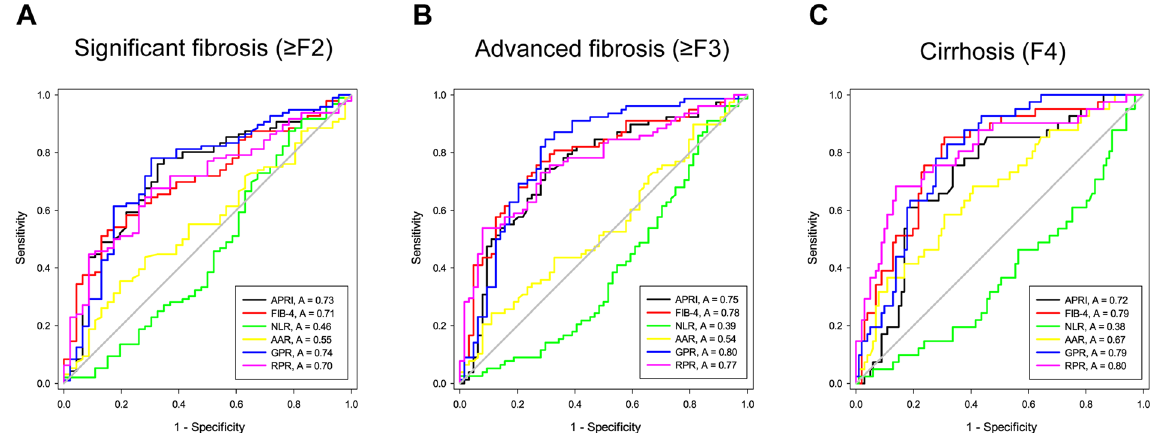
Figure 3. Receiver operating characteristic (ROC) curves of APRI, FIB-4, NLR, AAR, RPR and GPR in the prediction of significant liver fibrosis ( A ), advanced liver fibrosis ( B ) and liver cirrhosis ( C ) in HBeAg positive